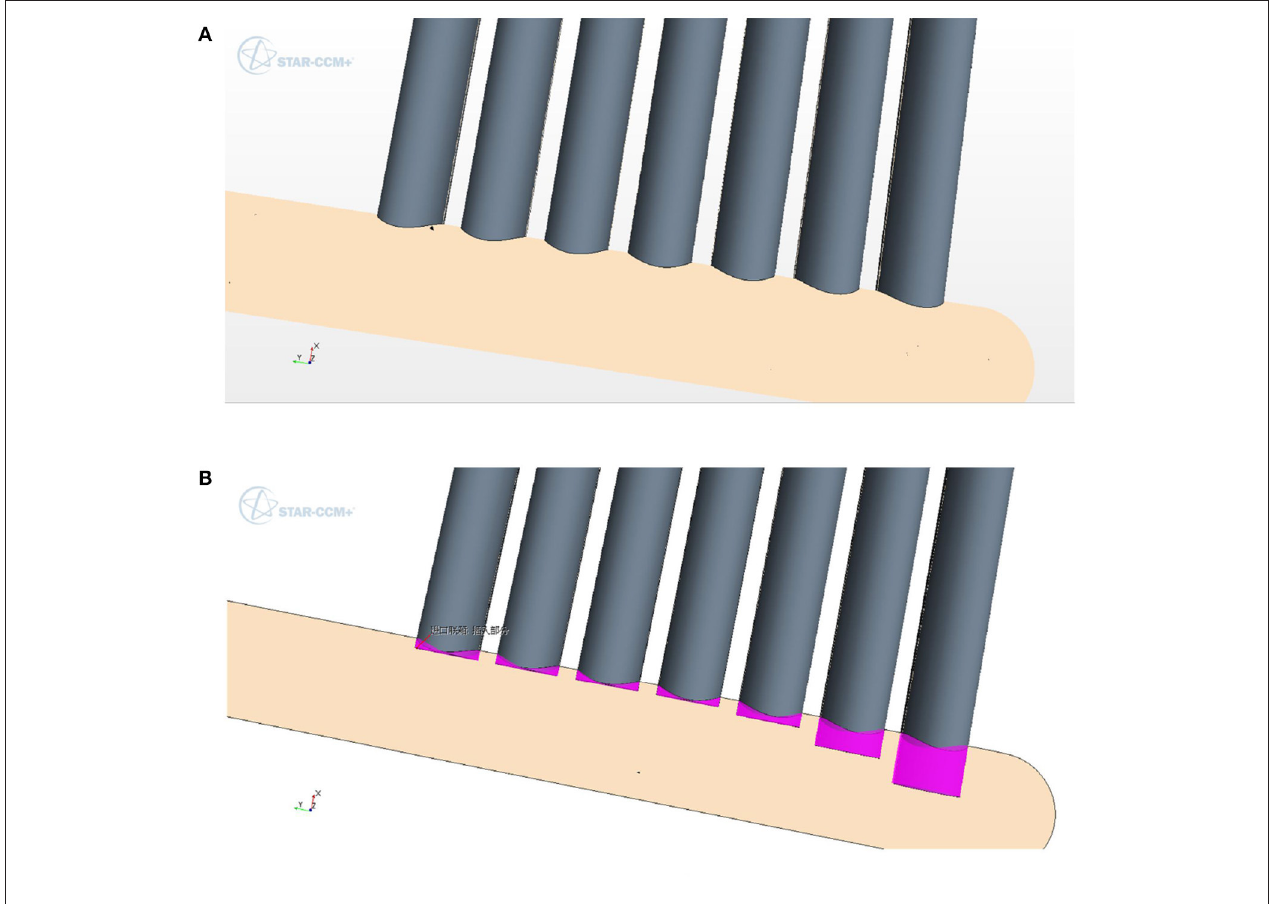
FIGURE 1 | (A) The conventional design. (B) The promotion of